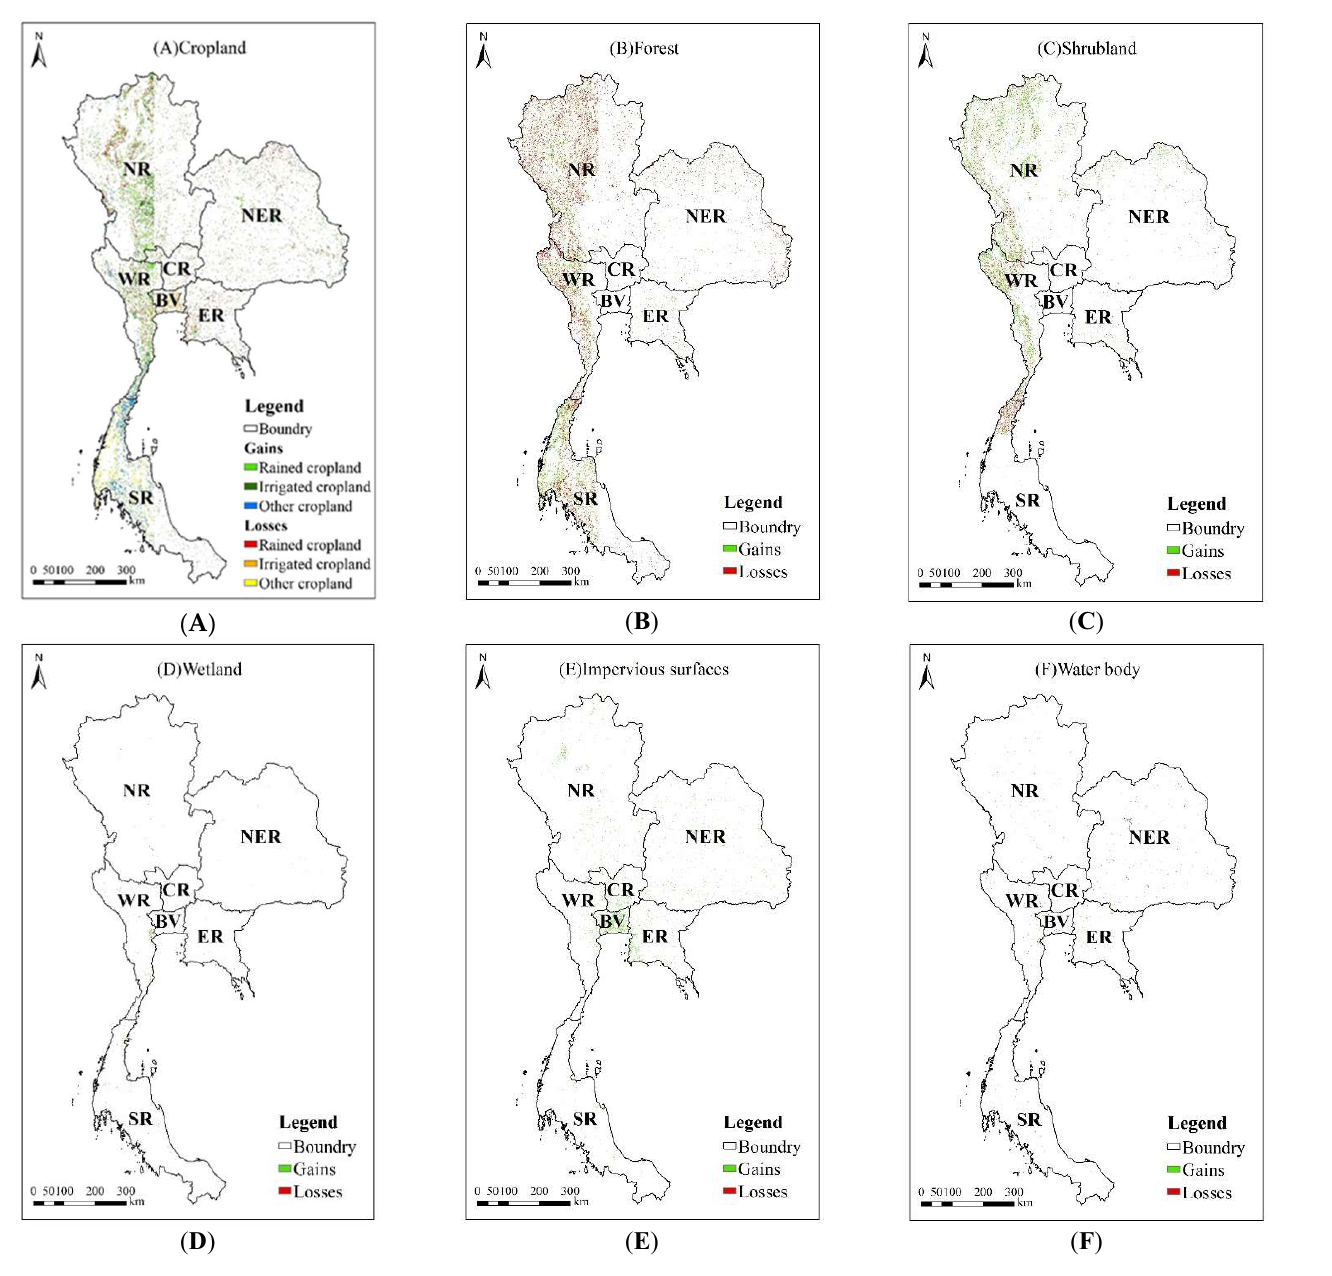
Figure 5. Spatial distributions of different LULC gains/losses during 2000–2020. NR: northern region. ( A ) Cropland; ( B ) Forest; ( C ) Shrubland; ( D ) Wetland; ( E ) Impervious surfaces; ( F ) Water body. Region: NER: northeastern region; CR: central region; WR: western region; ER: eastern region; BV: Bangkok and its vicinity; SR: southern region.